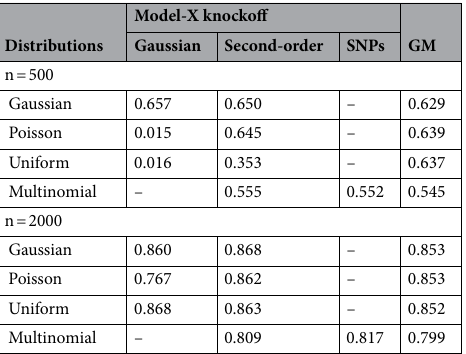
Table 2. The power when explanatory variables follow different distributions (Target FDR =